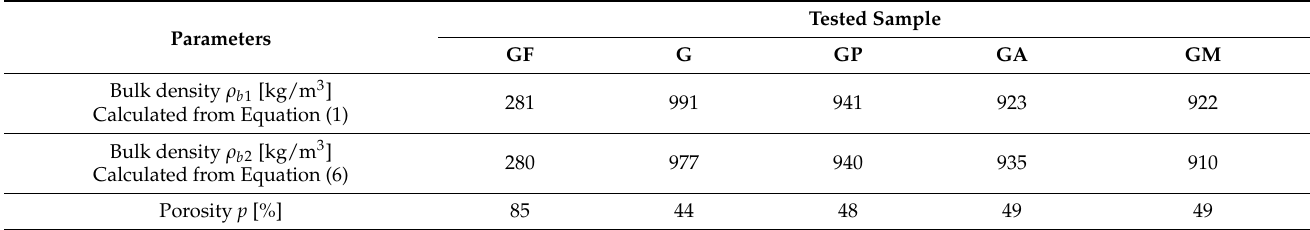
Table 2. The calculated bulk density and porosity of the tested samples.